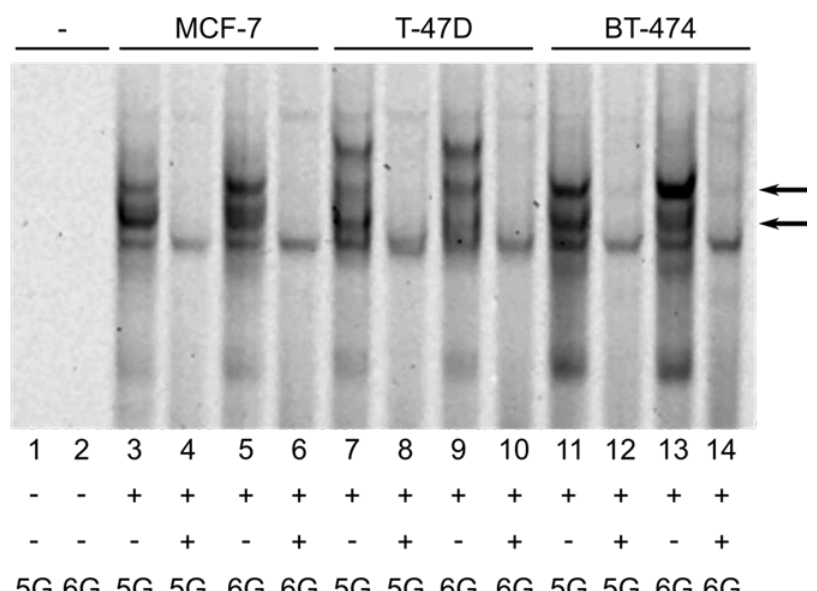
Figure 4. Electromobility shift assay (EMSA) revealing allele-dependent binding of nuclear proteins from different breast cancer cell lines to the locus of rs3215788 ( FNTB -173 6G > 5G). Bands resulting from specific DNA–protein binding disappeared upon incubation with an excess of unlabelled competitor oligonucleotides. Consistently for all cell lines examined, one specific band (upper arrow) was clearly stronger with the major 6G allele than with the 5G allele; conversely, another specific band (lower arrow) was more pronounced after incubation with the 5G allele.